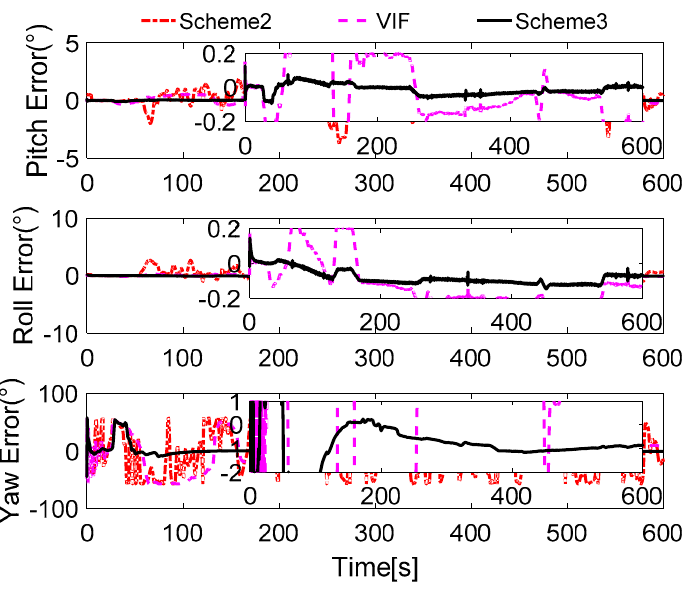
Figure 19. Curves of alignment errors.